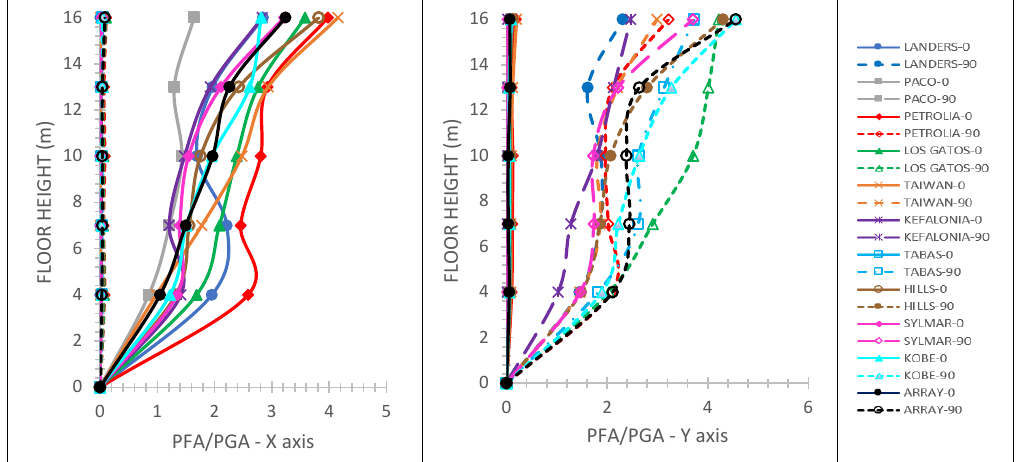
Figure 17. PFA/PGA along X ( left ) and Y ( right ) horizontal directions of the five-story mixed building, considering the fixed connection of the steel structure to the r/c one.